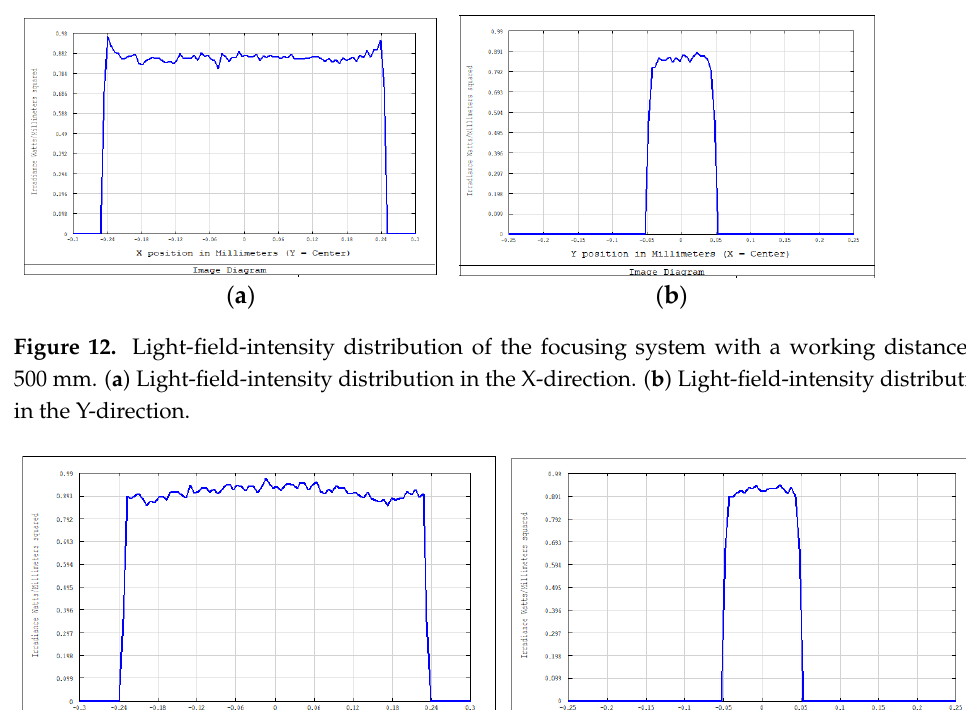
Figure 11. Optical structure of the focusing lens system.